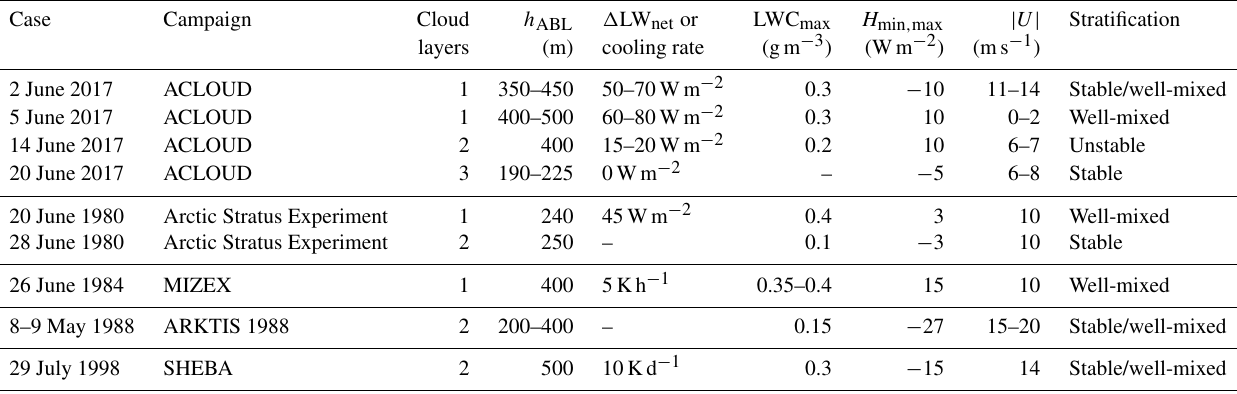
Figure 15. Sensitivity of the sensible heat flux profile (a) and vertical velocity variance (b) obtained from the mixed-layer model to the value of latent heat flux at the bottom of the mixed layer ρL e ( w (cid:48) q (cid:48) t ) 0 and to the value of the jump of total specific humidity at the top of the mixed layer (cid:49)q t . Vertical velocity variance is obtained using the parameterization of Lenschow et al. (1980) (Eq. C17) with the original values of c 1 and c 2 . Table 2. Summary of the observed cases during ACLOUD in comparison with earlier turbulence observations in stratocumulus-topped ABL over the Arctic sea ice in